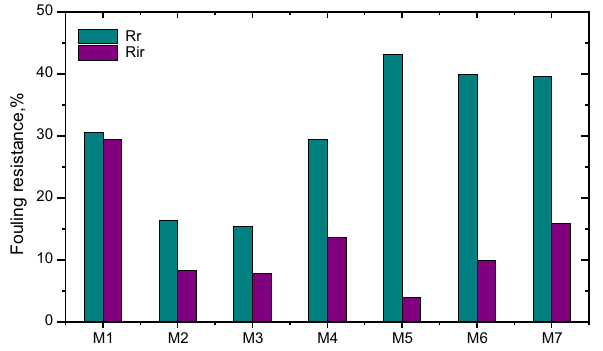
Fig. 8 Fouling resistance of the fabricated